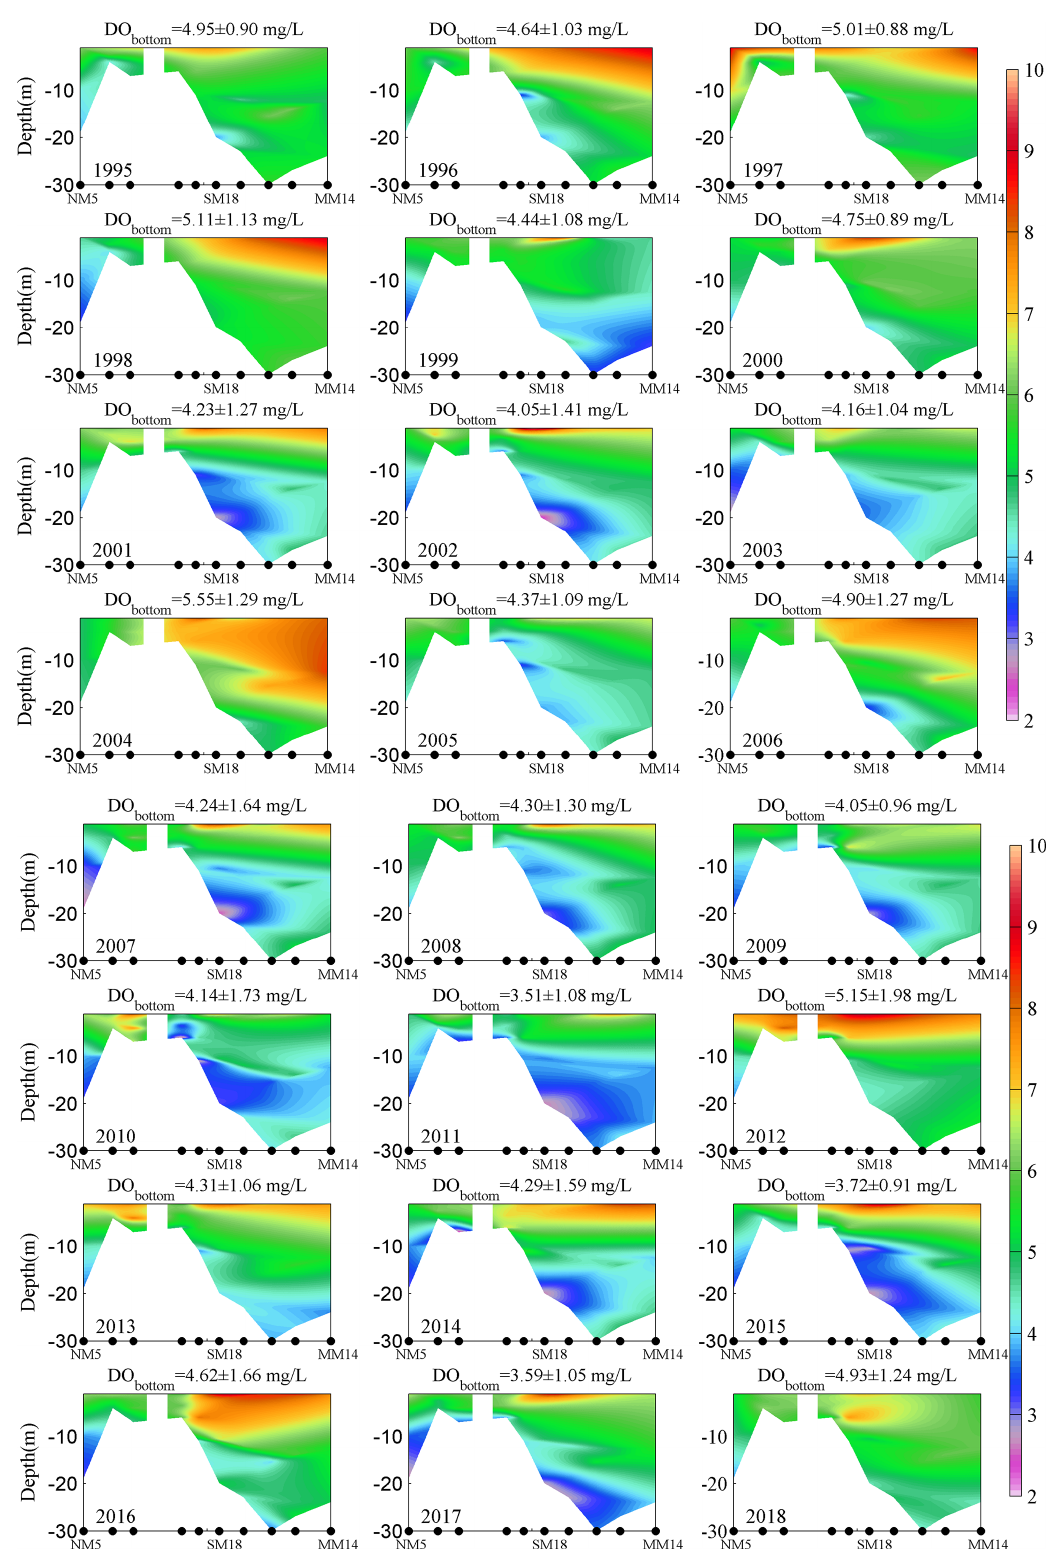
Figure A1. Vertical distributions of average DO of all summer cruises (3 months). Note that the mean values and standard deviations of bottom-water DO are also shown at the top of each